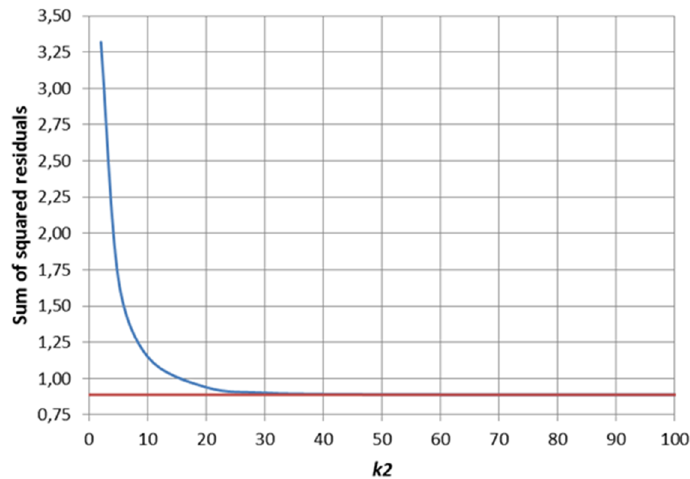
Figure 9. The sum of the squared residuals as a function of the rate parameter k 2 of the fast reaction step 2 in the general case of a parallel reaction system compared to the special case ( k 1 = 1, K 1 = 10 and K 2 =